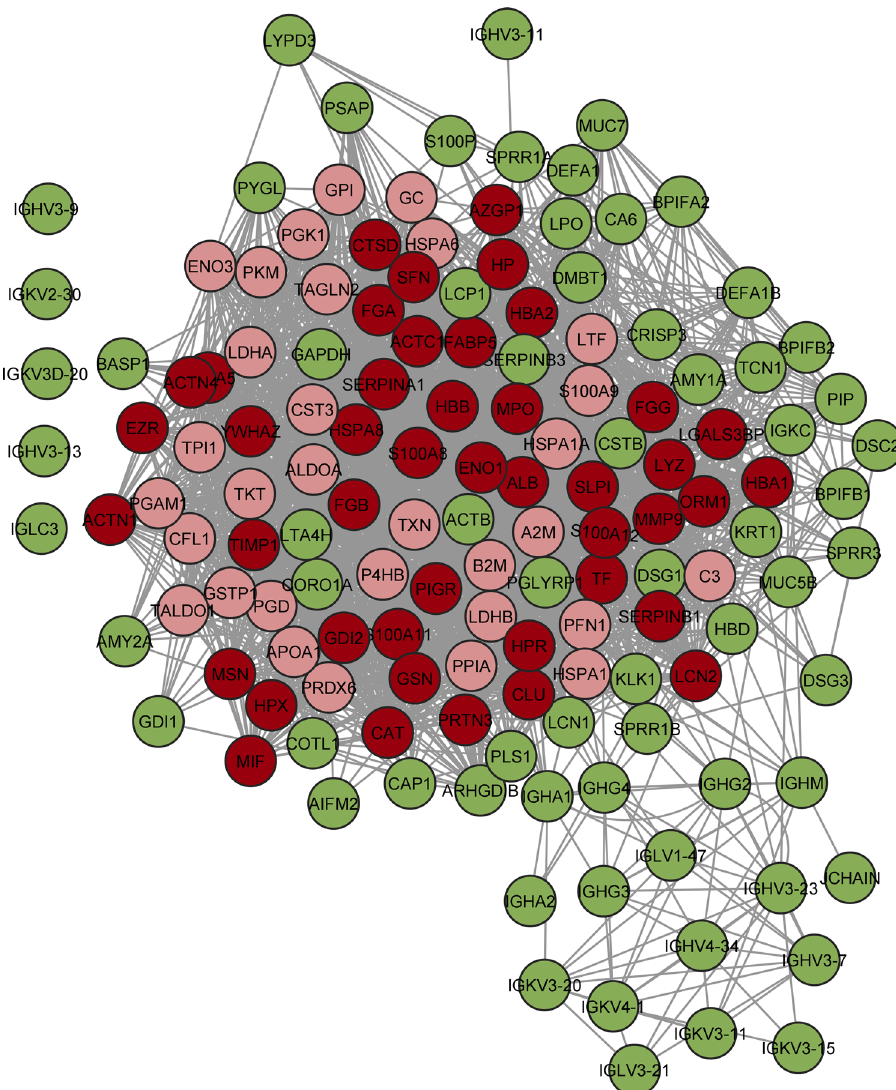
Figure 5: Top two cluster networks generated from the complex PPI network by the Molecular Complex Detection ( MCODE ) plug - in in Cytoscape. The nodes are represented by circles ( green – unclustered, red – cluster 1, and pink – cluster 2 ) and edges as lines ( gray )